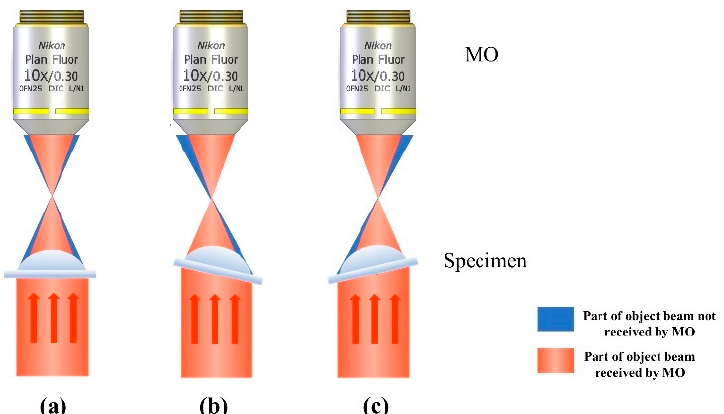
Figure 2. Schematic diagram of beam collection at multiple rotation angle. ( a ) the rotation angle is 0° around the R_X -axis, 0° around the R_Y-axis. ( b ) the rotation angle is 15° around the R_X-axis, 0° around the R_Y-axis. ( c ) the rotation angle is –15° around the R_X-axis, 0° around the R_Y-axis.